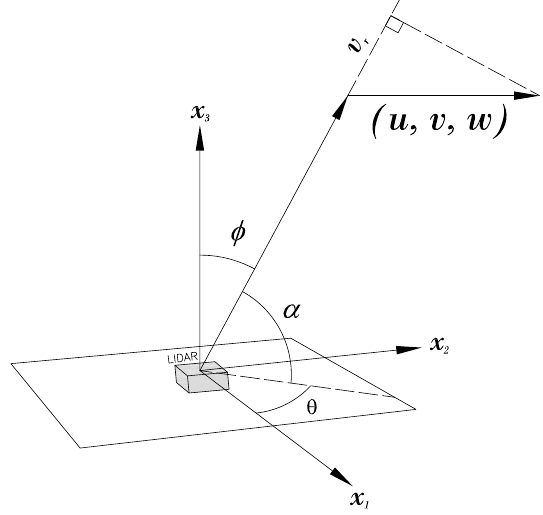
Fig. 1. Schematic of the lidar operating in a staring